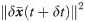
Approximation of the nonlinear error growth at different phases.We inspect whether nonlinear error growth can be approximated by the linearized system at different stages of the outbreak. Starting from t = 5 weeks, we display the error ‖δx¯(t+δt)‖2 in the following week obtained from simulation with full nonlinearity (blue lines), and compare it with approximations using a linear extrapolation (1+λ1δt)‖δx¯(t)‖2 (red lines) and an exponential growth exp(λ1δt)‖δx¯(t)‖2 (yellow lines). The initial error is set as ‖δx¯(t)‖2=1. The growth rate λ is calculated from Eq 20, where η(S) = 103 and η(I) = 102. The same analyses at t = 10, 15 and 20 weeks are shown in other insets. The epidemic curve is generated from the SIRS model forced by the humidity condition for New York City starting from October 1st. The exponential approximation agrees well with the simulated error at 5 and 10 weeks, whereas the linear approximation is only valid within a short time period. At weeks 15 and 20 (after peak), both the exponential and linear approximations give satisfactory estimates of the nonlinear simulation.